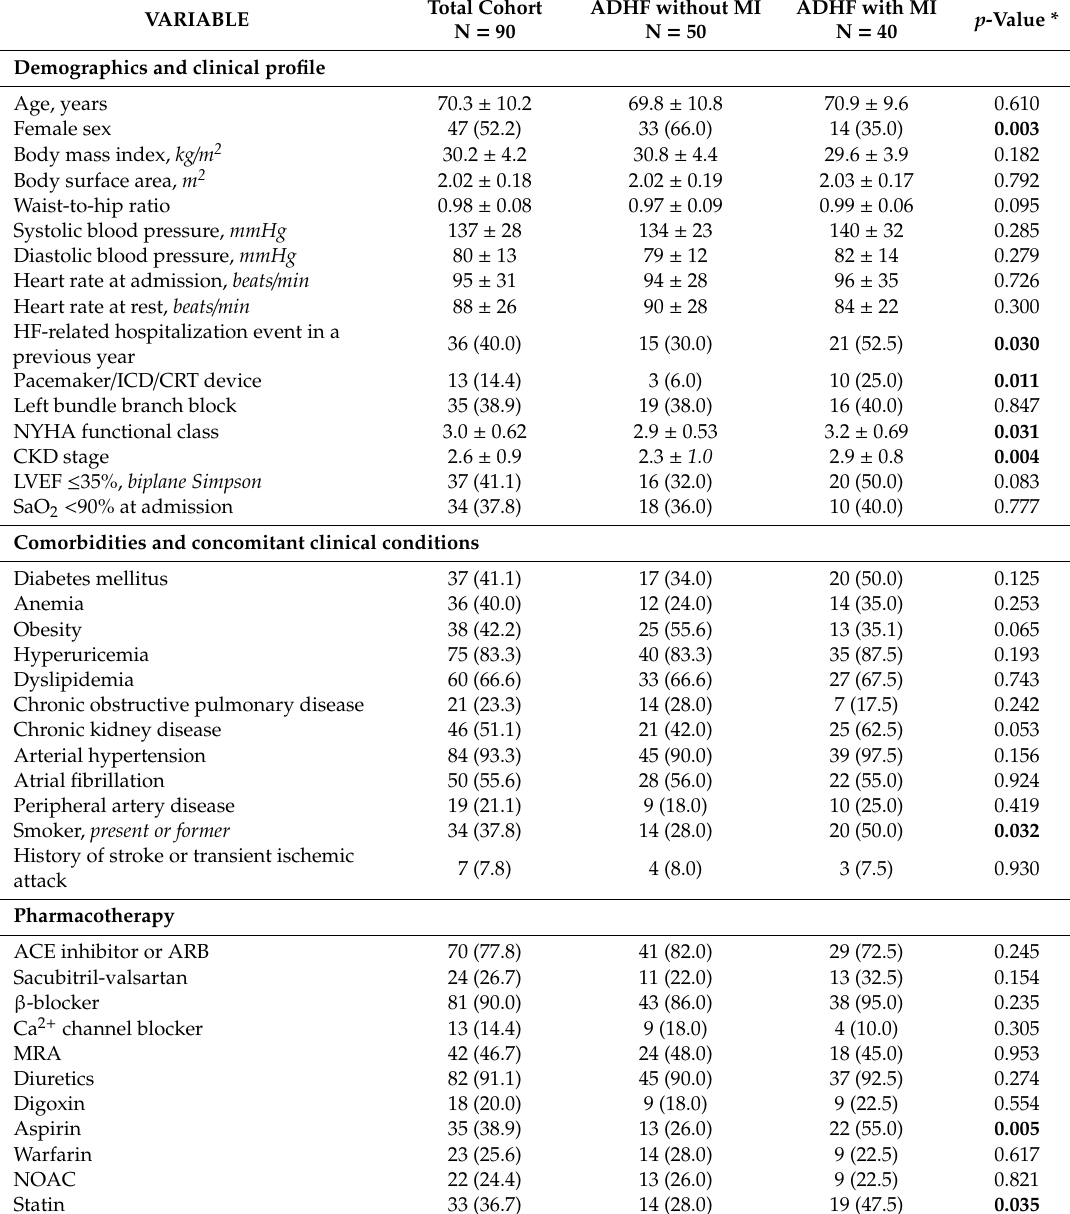
Table 1. Baseline data and pharmacotherapy of the enrolled cohort stratified by the positive history of myocardial